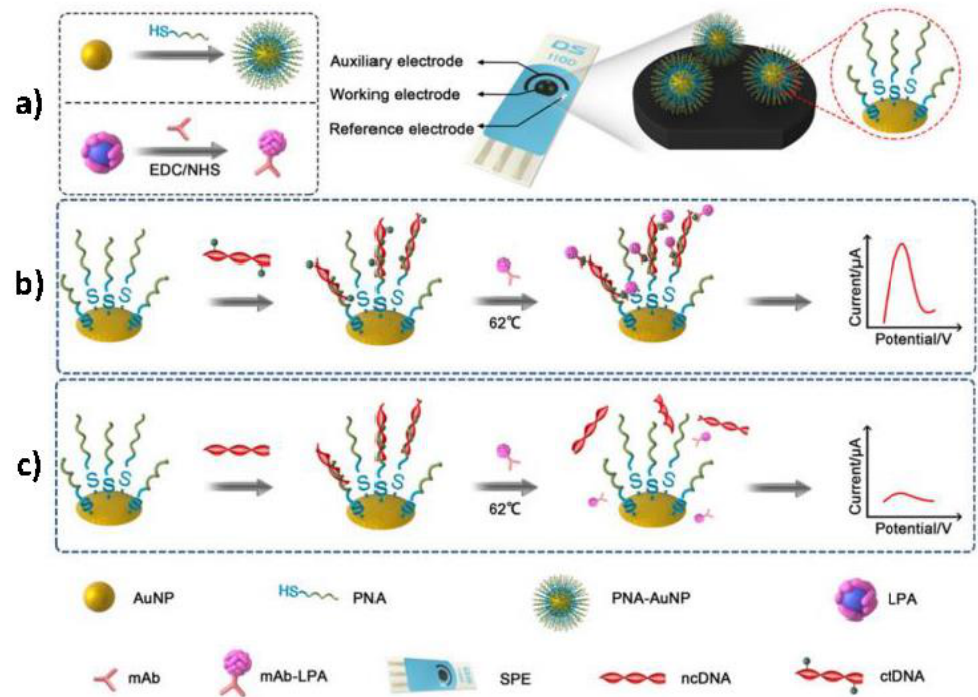
Figure 6. Schematic displays showing the preparation of PNA-AuNPs conjugates and LPA-anti-5-mC bioconjugates ( a ) and the ctDNA ( b ) and ncDNA ( c ) detection at the constructed biosensor. Reprinted and adapted from [31] with permission.